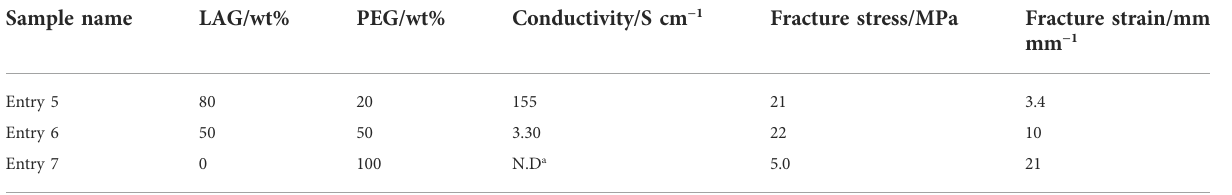
TABLE 4 Mechanical properties of the LAG-PEG composite fi